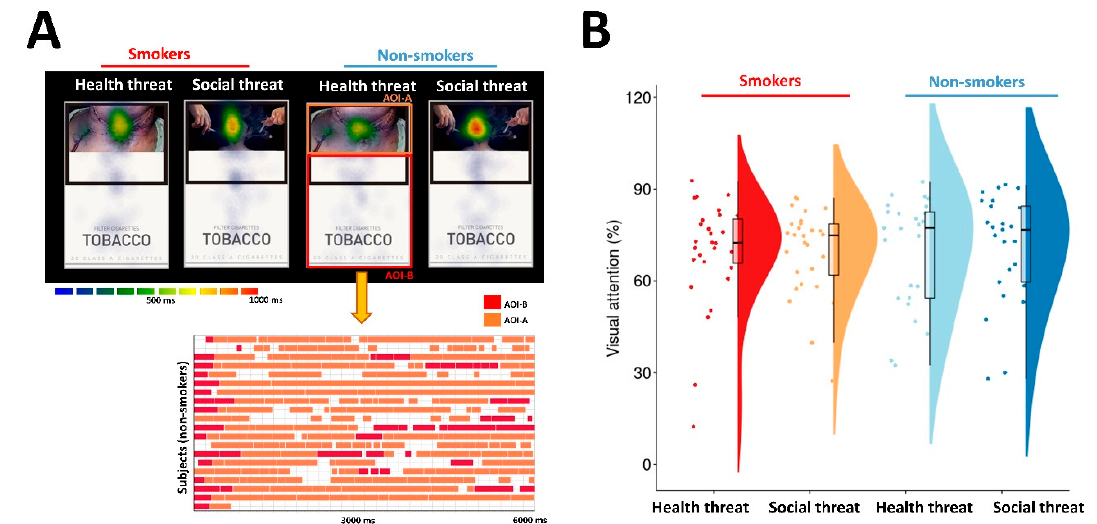
Figure 3. Visual attention to graphic health warnings on cigarette packs. A : Examples of the eye movements in response to graphic health warnings (GHWs) in smokers and non-smokers. B : Visual attention to two di ff erent types of GHWs was compared between smokers and non-smokers. There was no significant di ff erence in visual attention between the two di ff erent types of GHWs in both smokers and non-smokers.